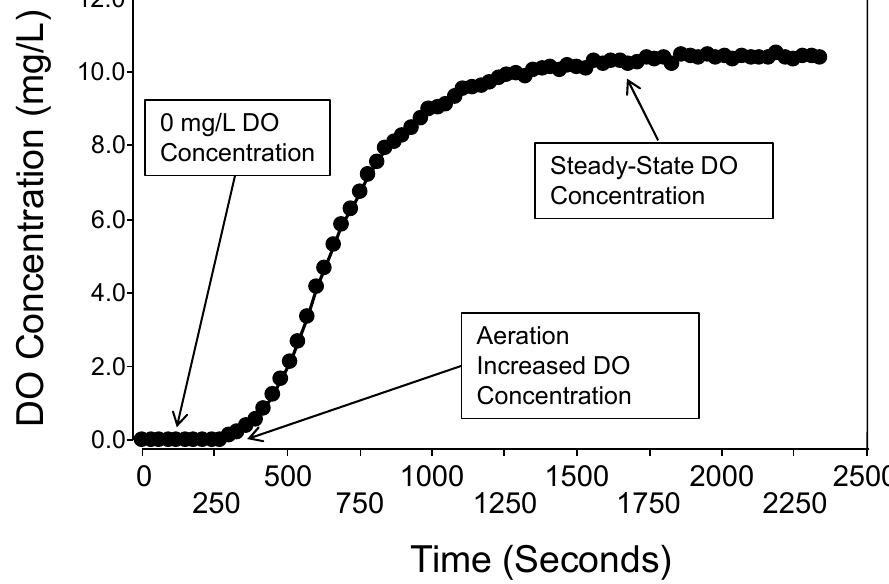
Figure 2. Example dissolved oxygen (DO) profile showing the changing DO concentration during oxygen transfer test.